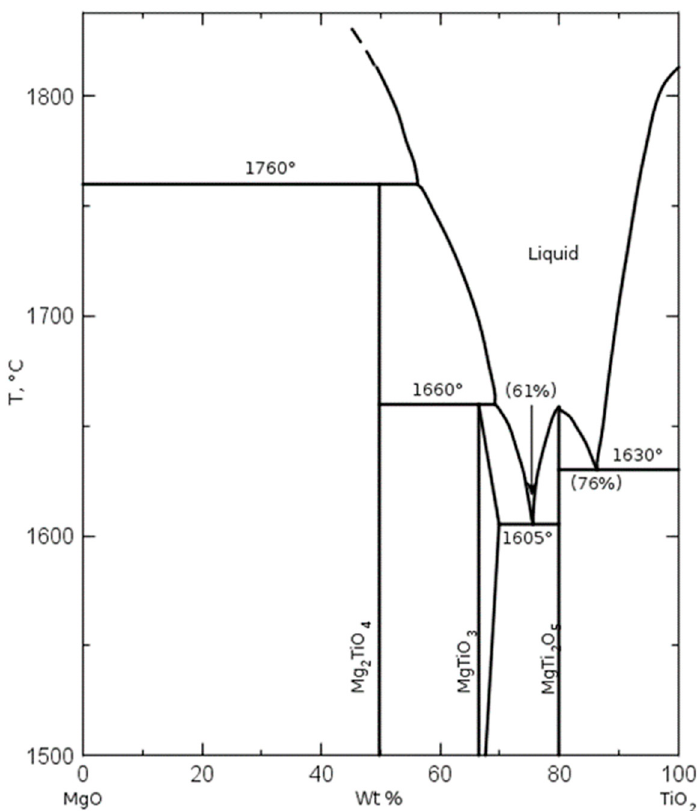
Figure 17. Phase diagram of MgO and TiO 2 showing the phases formed with different contents of the substances at different temperatures [35].